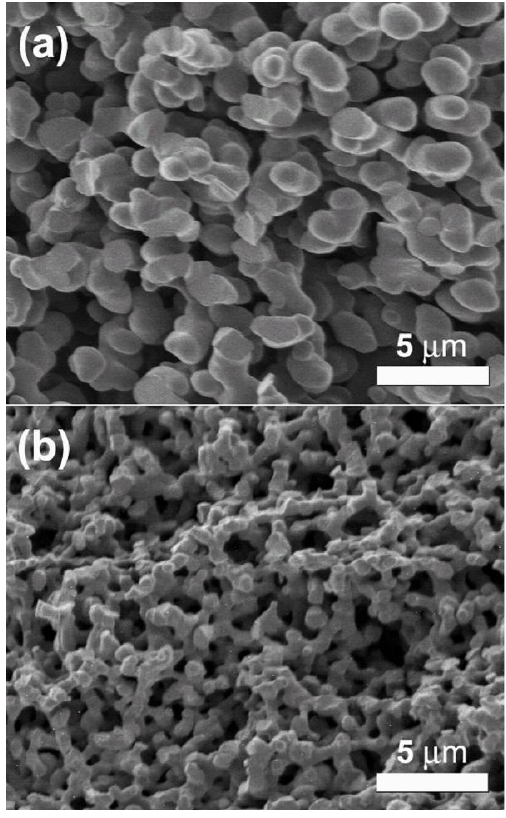
Figure 8. SEM images of (a) the pre-activated CA and (b) an activated CA with surface area of 3,200 m 2